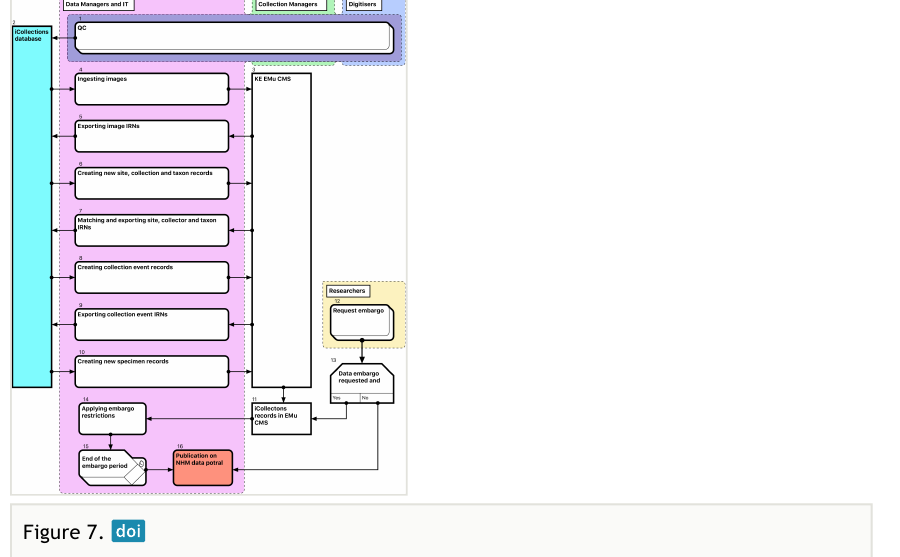
Module 4 (Ingest and dissemination work fl ow). Bracketed numbers in the following text reference the work fl ow steps in this